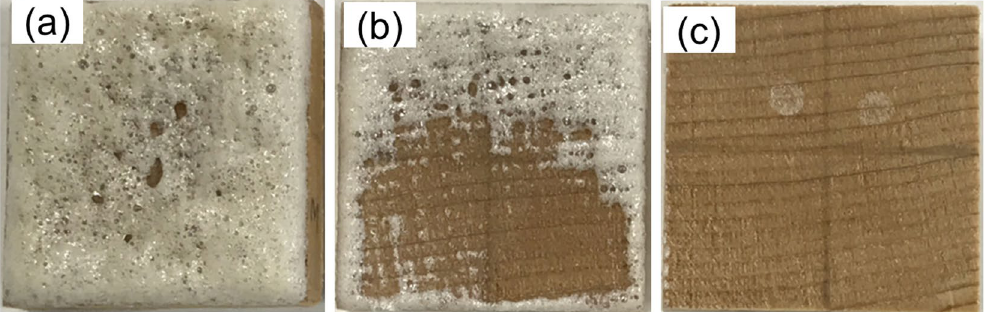
Figure 7. Representative photographs of the MF-impregnated wood after conditioned at RH of 11% ( a ), 43% ( b ), and 75% ( c ), and subsequently vacuum